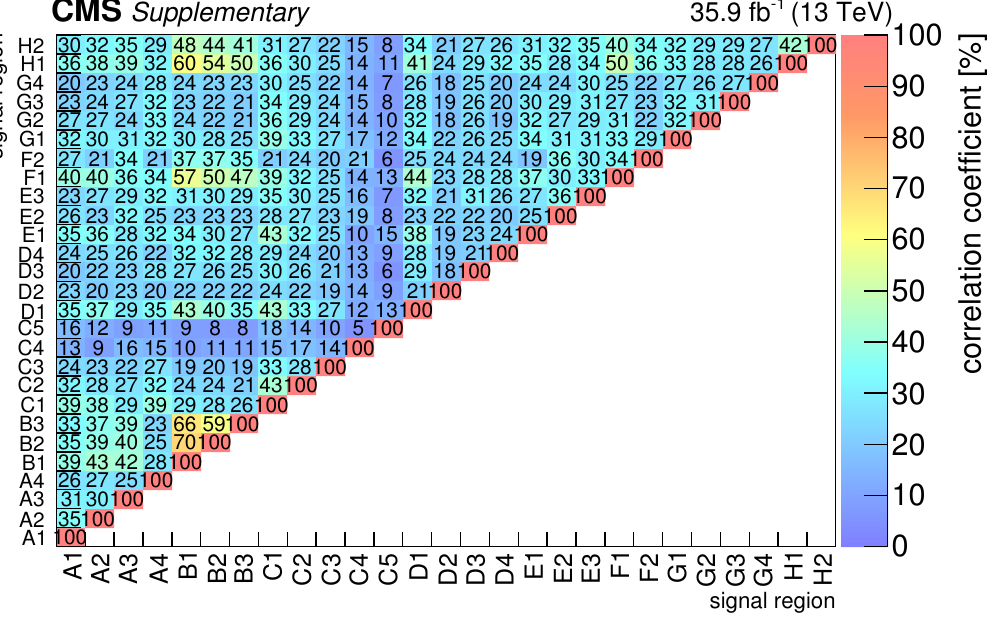
Figure 8 . Correlation matrix for the background predictions for the signal regions for the standard selection (in percent). The labelling of the regions follows the convention of (cid:12)gure 4.